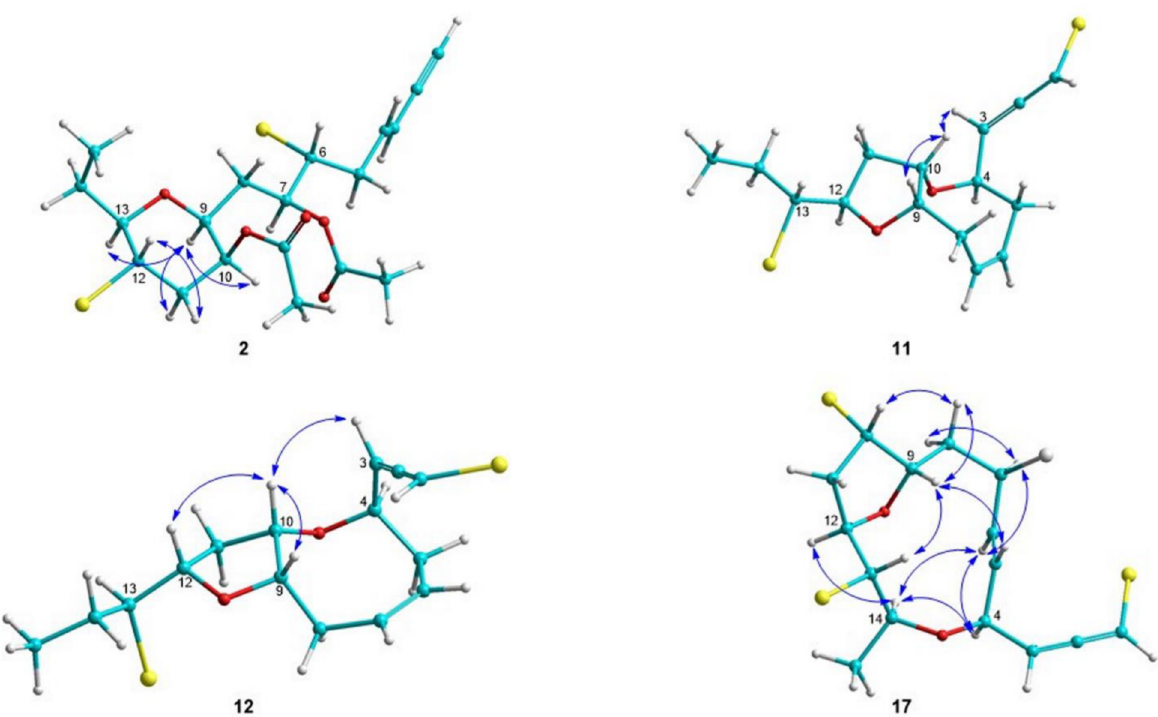
Figure 3. Key NOE correlations observed for compounds 2 , 11 , 12 and 17